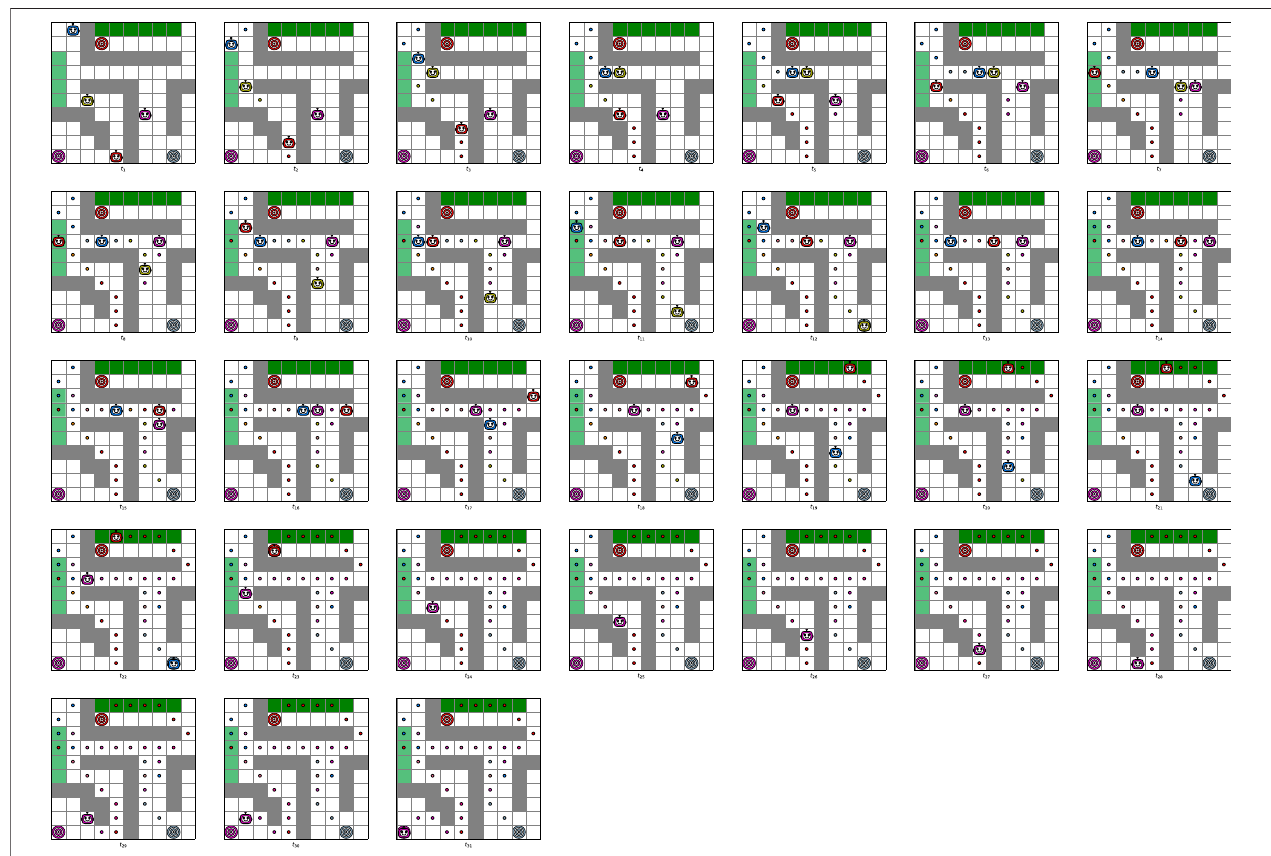
FIGURE7| Representationofthemovementoffouragentsin stochasticenvironmentwitha5%chanceoferroronneighboringactions and eightpossible actions { top-left, up, top-right, left, right, down-left, down, down-right }.